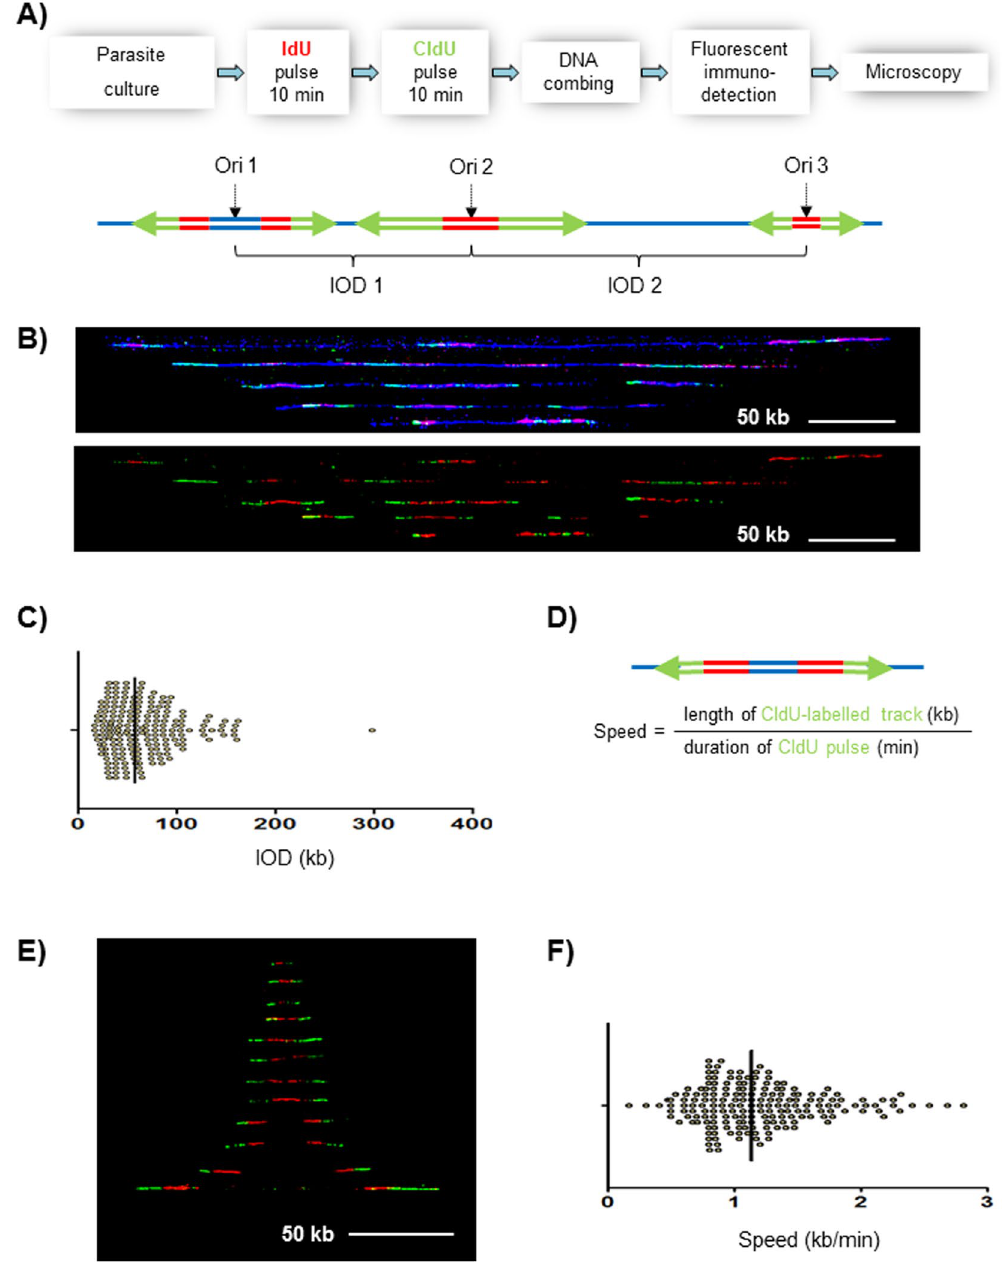
Figure 1. DNA fibre labelling to measure replication fork rates and inter-origin spacing in blood-stage P. falciparum parasites. ( A ) Upper panel: Outline of the experimental approach. Blood-stage P . falciparum parasites were successively labelled with 10-minute pulses of IdU and CldU, then chromosomal DNA was combed on silanized coverslips. DNA (blue) and modified nucleotides (IdU, red; CldU, green) were immuno-detected. Lower panel: Schematic showing some of the signal patterns observed on labelled DNA fibres. The presumed positions of the replication origins are indicated in the middle between bidirectional replication forks (Ori 1–3). The inter-origin distance (IOD) was measured as centre to centre distance between two adjacent progressing bidirectional forks. Green arrows represent the direction of the replication forks’ progression. ( B ) Representative DNA fibres from mixed-stage parasites. Upper panel: DNA fibres are in blue, IdU in red and CldU in green; lower panel show the IdU and CldU tracks extracted from the upper panel. 50 kb scale bars are indicated. ( C ) Dot plot showing distribution of inter-origin distances (IODs) measured in asynchronous blood stage forms of P . falciparum . Black bar represents the median value. ( D ) Schematic showing bidirectional replication forks. Replication fork velocity was calculated by dividing the green CldU track length by the duration of the second, CldU, pulse. ( E ) Bidirectional replication forks taken from different microscopic fields were artificially assembled and centred to the position of the presumed origins. Red tracks, IdU; green tracks, CldU. For clarity, counterstaining of DNA is not shown. Scale bar, 50 kb. ( F ) Dot plot showing distribution of replication fork speeds measured in asynchronous blood stage forms of P . falciparum . Black bar represents the median